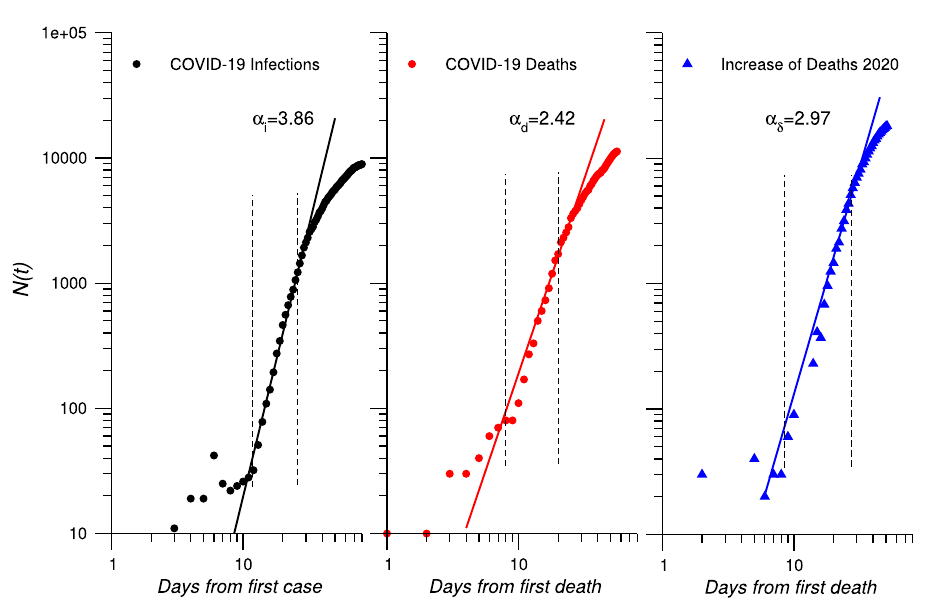
Figure 1. Log–Log plots of total cumulative number of COVID-19 infections starting from 25th February (first case in Liguria), cumulative number of COVID-19 deaths and cumulative increase of deaths starting from 4th March (first deaths in Liguria) for Liguria until 15th April 2020. Best fit lines according to Eq. (4) are superimposed to the observed data. Vertical dashed lines indicate the fitting